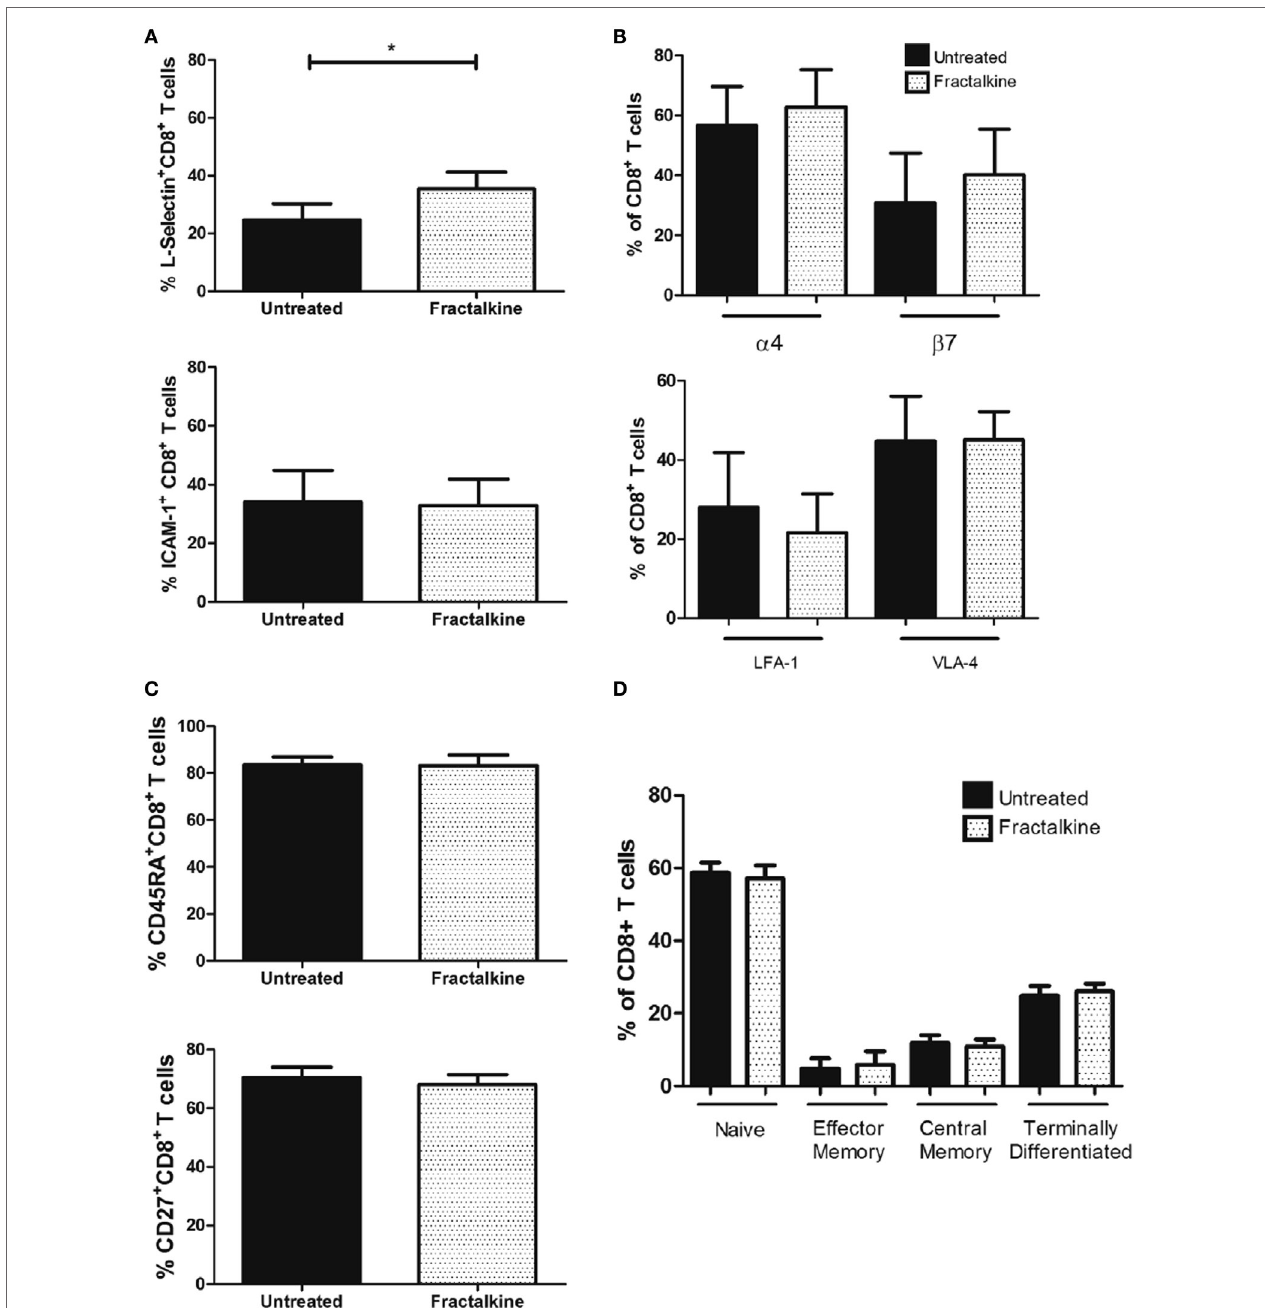
FigUre 6 | The fractalkine-mediated CX3CR1 INT to CX3CR1 NEG conversion of CD8 + T cells is followed by enhanced L-selectin expression. (a) Bar charts showing frequencies of peripheral blood-derived CD8 + T cells expressing L-selectin (top) and ICAM-1 (bottom) following treatment with M199 media alone (untreated, black) or 30 ng/ml of recombinant fractalkine for 24 h (fractalkine, white pattern) ( n = 6). (B) Bar chart (top) showing frequencies of peripheral blood-derived CD8 + T cells expressing alpha4 and beta7 integrins following treatment with M199 media alone (untreated, black) or 30 ng/ml of recombinant fractalkine for 24 h (fractalkine, white pattern) ( n = 6). (B) Bar chart (bottom) showing frequencies of peripheral blood-derived CD8 + T cells expressing LFA-1 and VLA-4 following treatment with M199 media alone (untreated, black) or 30 ng/ml of recombinant fractalkine for 24 h (fractalkine, white pattern) ( n = 6). (c) Bar chart showing the frequencies of total CD45RA + and CD27 + populations of CD8 + T cells following treatment with M199 media alone (untreated, black) or 30 ng/ml of recombinant fractalkine for 24 h (fractalkine, white pattern) ( n = 6). (D) Bar chart showing the frequencies of naive, effector memory, central memory, and terminally differentiated CD8 + T cells, characterized by CD45RA and CD27 expression following treatment with M199 media alone (untreated, black) or 30 ng/ml of recombinant fractalkine for 24 h (fractalkine, white pattern) ( n = 6). * p < 0.05 by paired t tests.